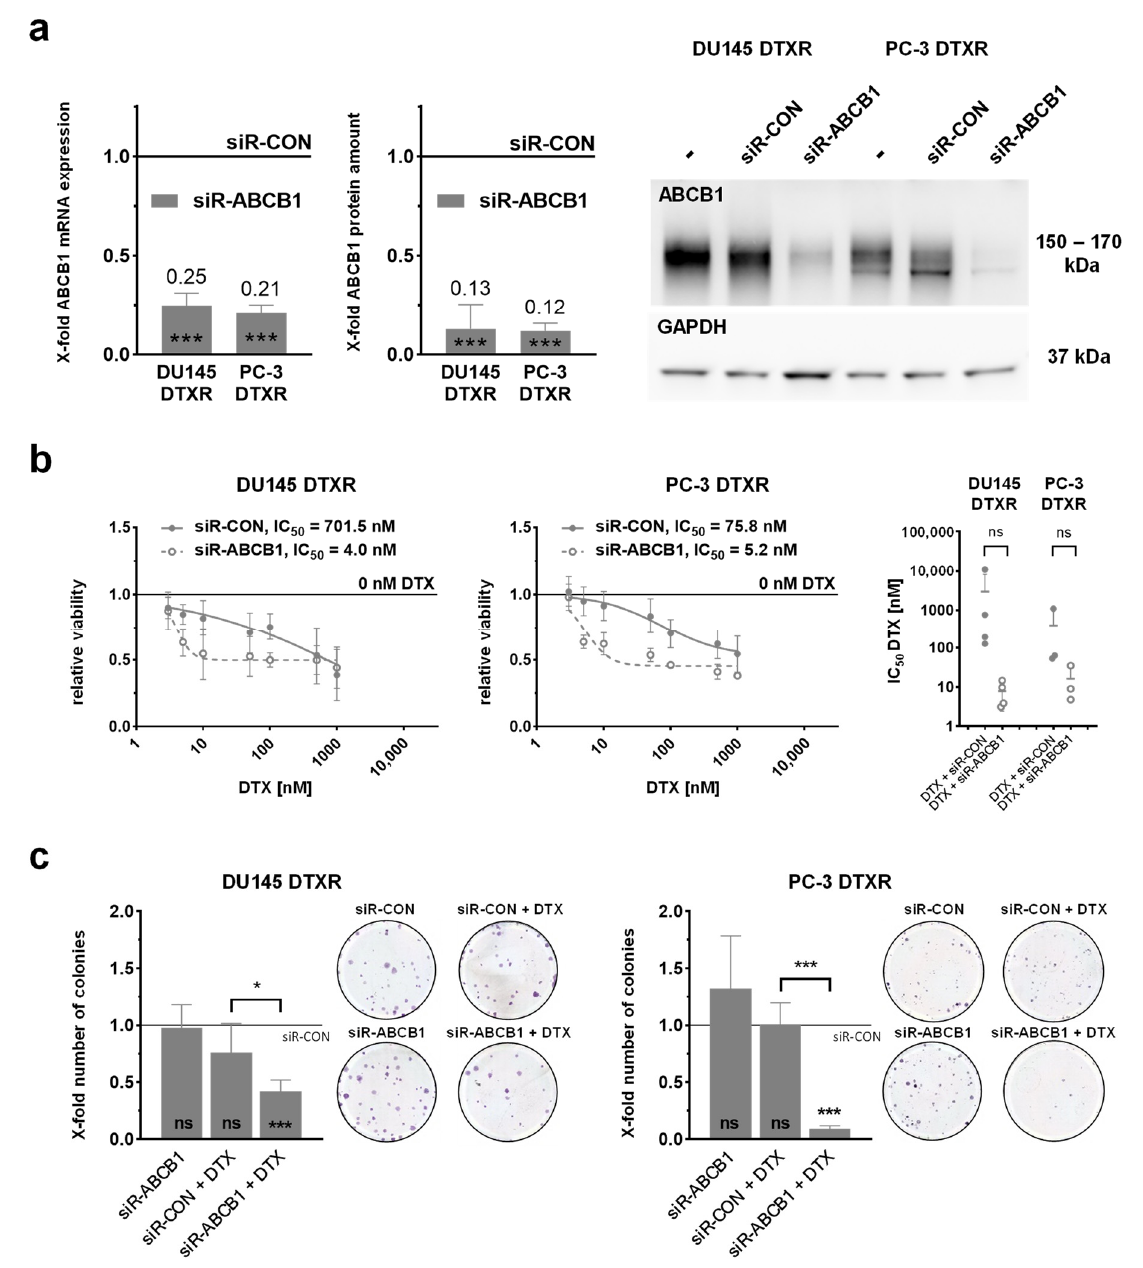
Figure 4. Influence of siRNA-mediated knockdown of ABCB1 in combination with DTX on cellular viability and clonogenic survival of DU145 and PC-3 DTXR cells. ( a ) The relative transcript and protein levels of ABCB1 in DTXR cells 96 h after siRNA transfection start are depicted. An exemplary Western blot for the detection of ABCB1 protein with GAPDH as reference protein is shown. ( b ) DU145 and PC-3 DTXR cells were treated with a serial dilution of DTX after transfection with either siR-CON or siR-ABCB1 (20 nM). After treatment, the metabolic activity was measured by the WST-1 assay and IC 50 values for DTX were calculated. The adjacent graphs to the right depict IC 50 values calculated from individual experiments. ( c ) DTXR cells were transfected with either siR-CON or siR-ABCB1 (20 nM) and 96 h after transfection start the cells were treated with 50 nM DTX. Thereafter, cell colony formation assays were seeded and cell colonies were counted after 10–12 d. Exemplary colonies are shown in the right panels. All data were normalized to the indicated control (black line). Data are depicted as mean ± SD of three to five independent biological replicates. ( a , c ) One-sample t-test for comparison to the siR-CON-treated controls and ( b , c ) non-paired t-test with Welch’s correction for comparison of two treatment groups: * p < 0.05, *** p < 0.001, ns: not significant.